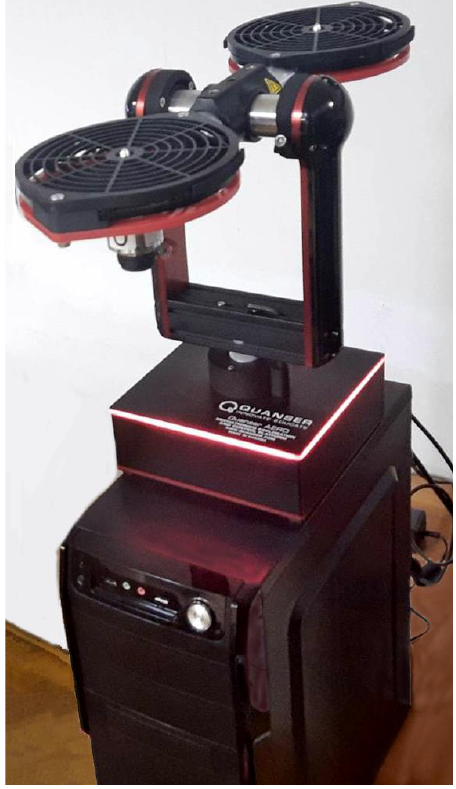
Figure 1. Quanser Aero 2 laboratory equipment with a 1-DOF configuration. Single-ended optical shaft encoders were used to measure the pitch of the Aero body and the angular speed of the DC motors [28]. The pitch encoder is 2880 counts per revolution in quadrature mode, and the angular speed encoder is a counter that returns the number of the encoder counts every second.